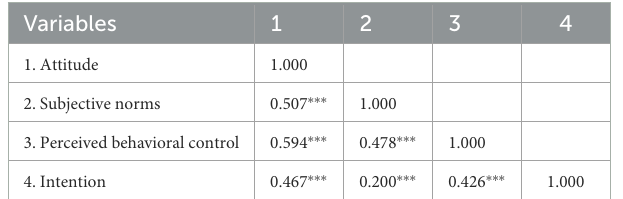
TABLE 4 Correlations among